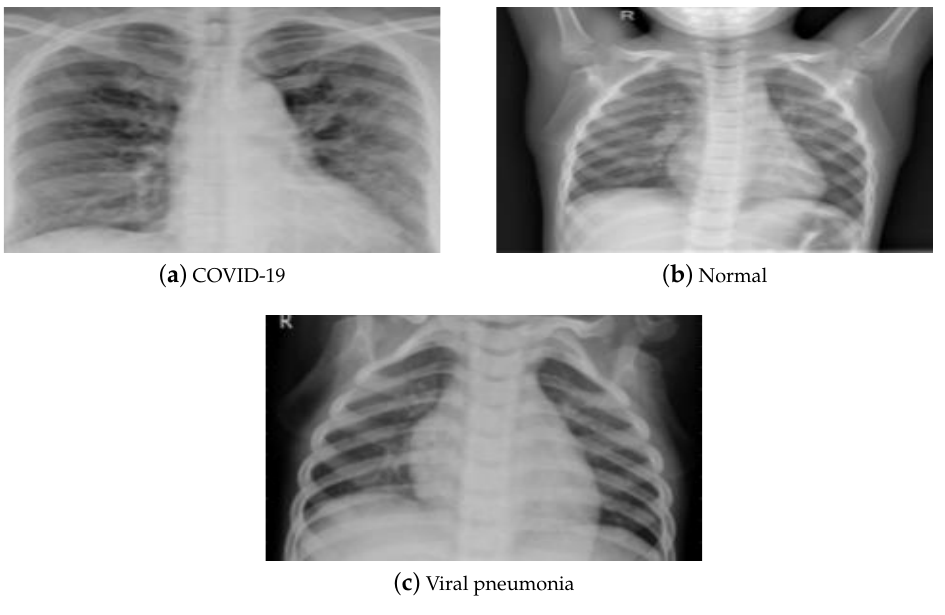
Figure 4. ( a – c ) X-ray data set samples [52].